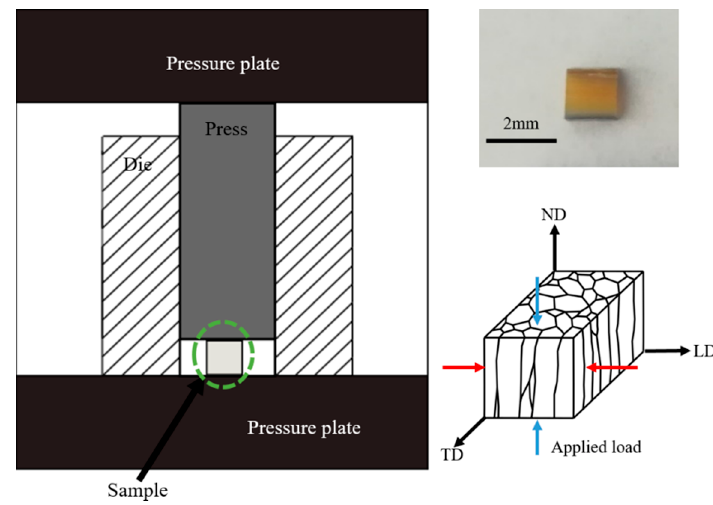
Figure 2. The scheme presenting the setup used for the determination of the strength of P. margaritifera shells and the image presenting the sample.